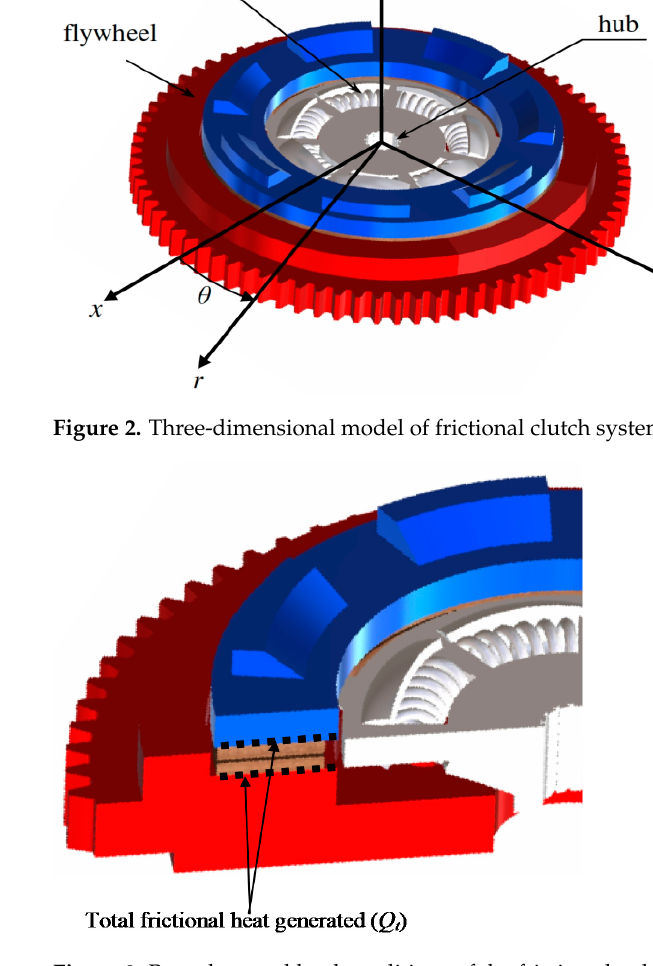
Figure 3. Boundary and load conditions of the friction clutch system.